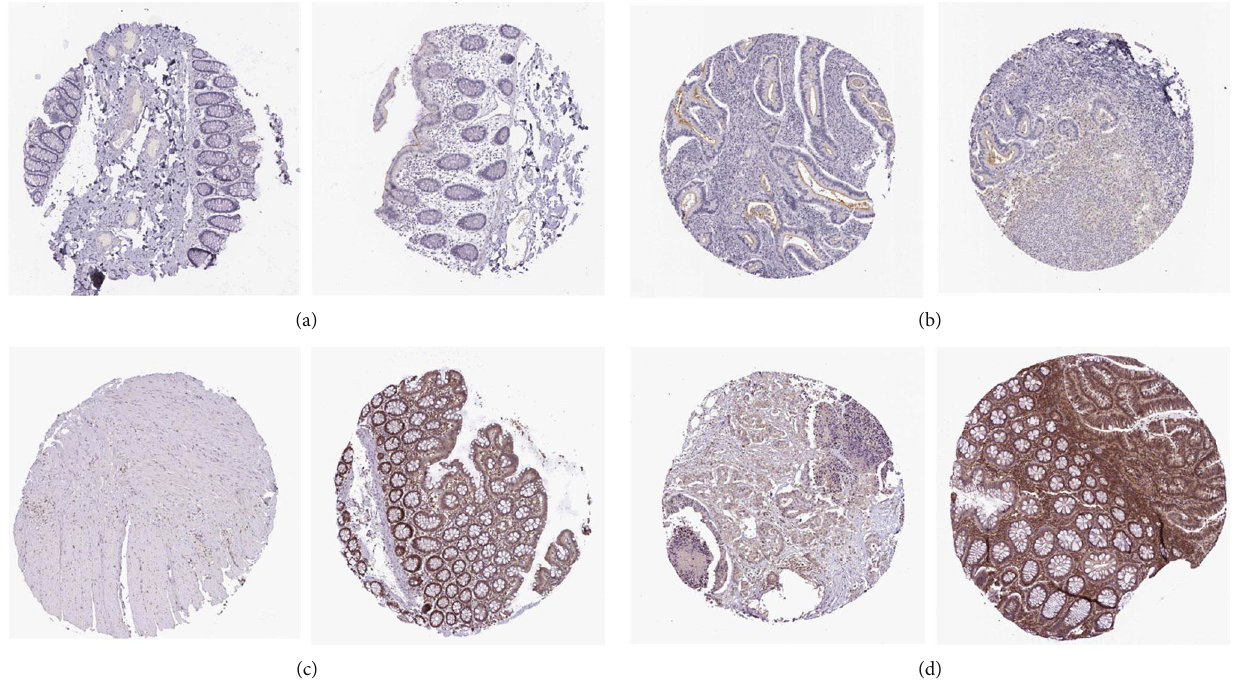
Figure 10: Immunohistochemical results of IL1RN and PRRX1 in normal tissues and CRC tissues. (a) IL1RN in normal tissues. (b) IL1RN in CRC tissues. (c) PRRX1 in normal tissues. (d) PRRX1 in CRC